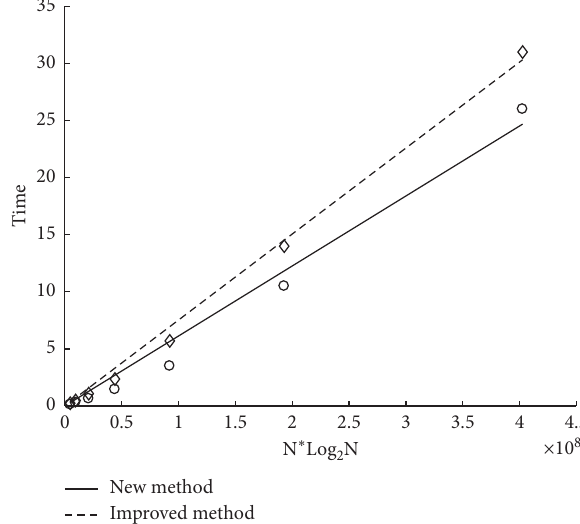
Figure 4: Construction time (seconds) for 2 18 ≤ N ≤ 2 24 4-di- mensional randomly generated real